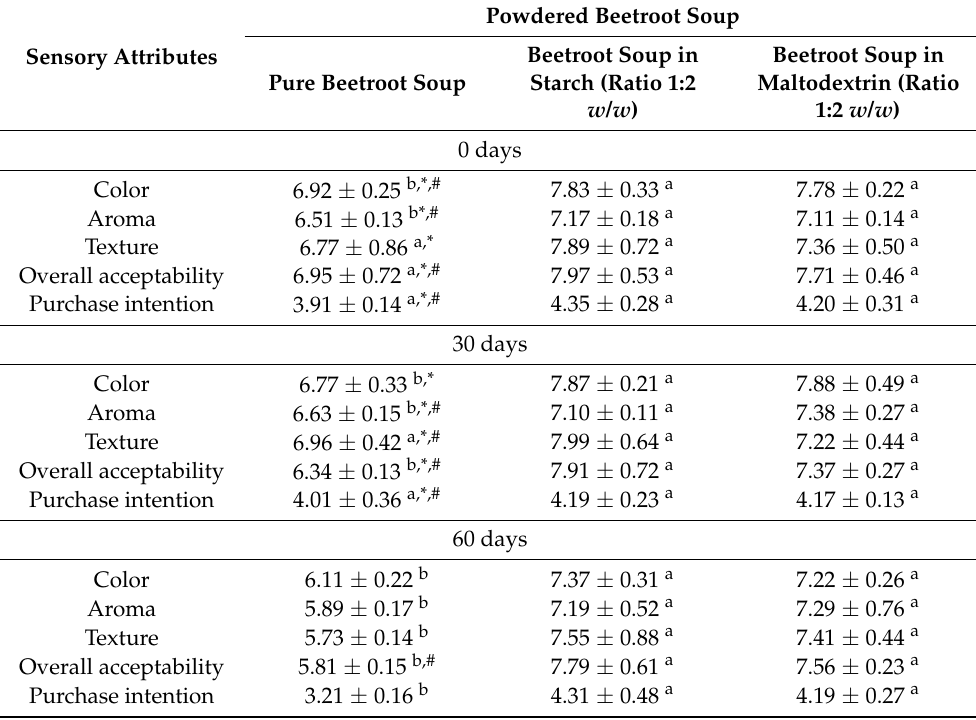
Table 5. Sensory analysis and purchase intent of powdered beetroot